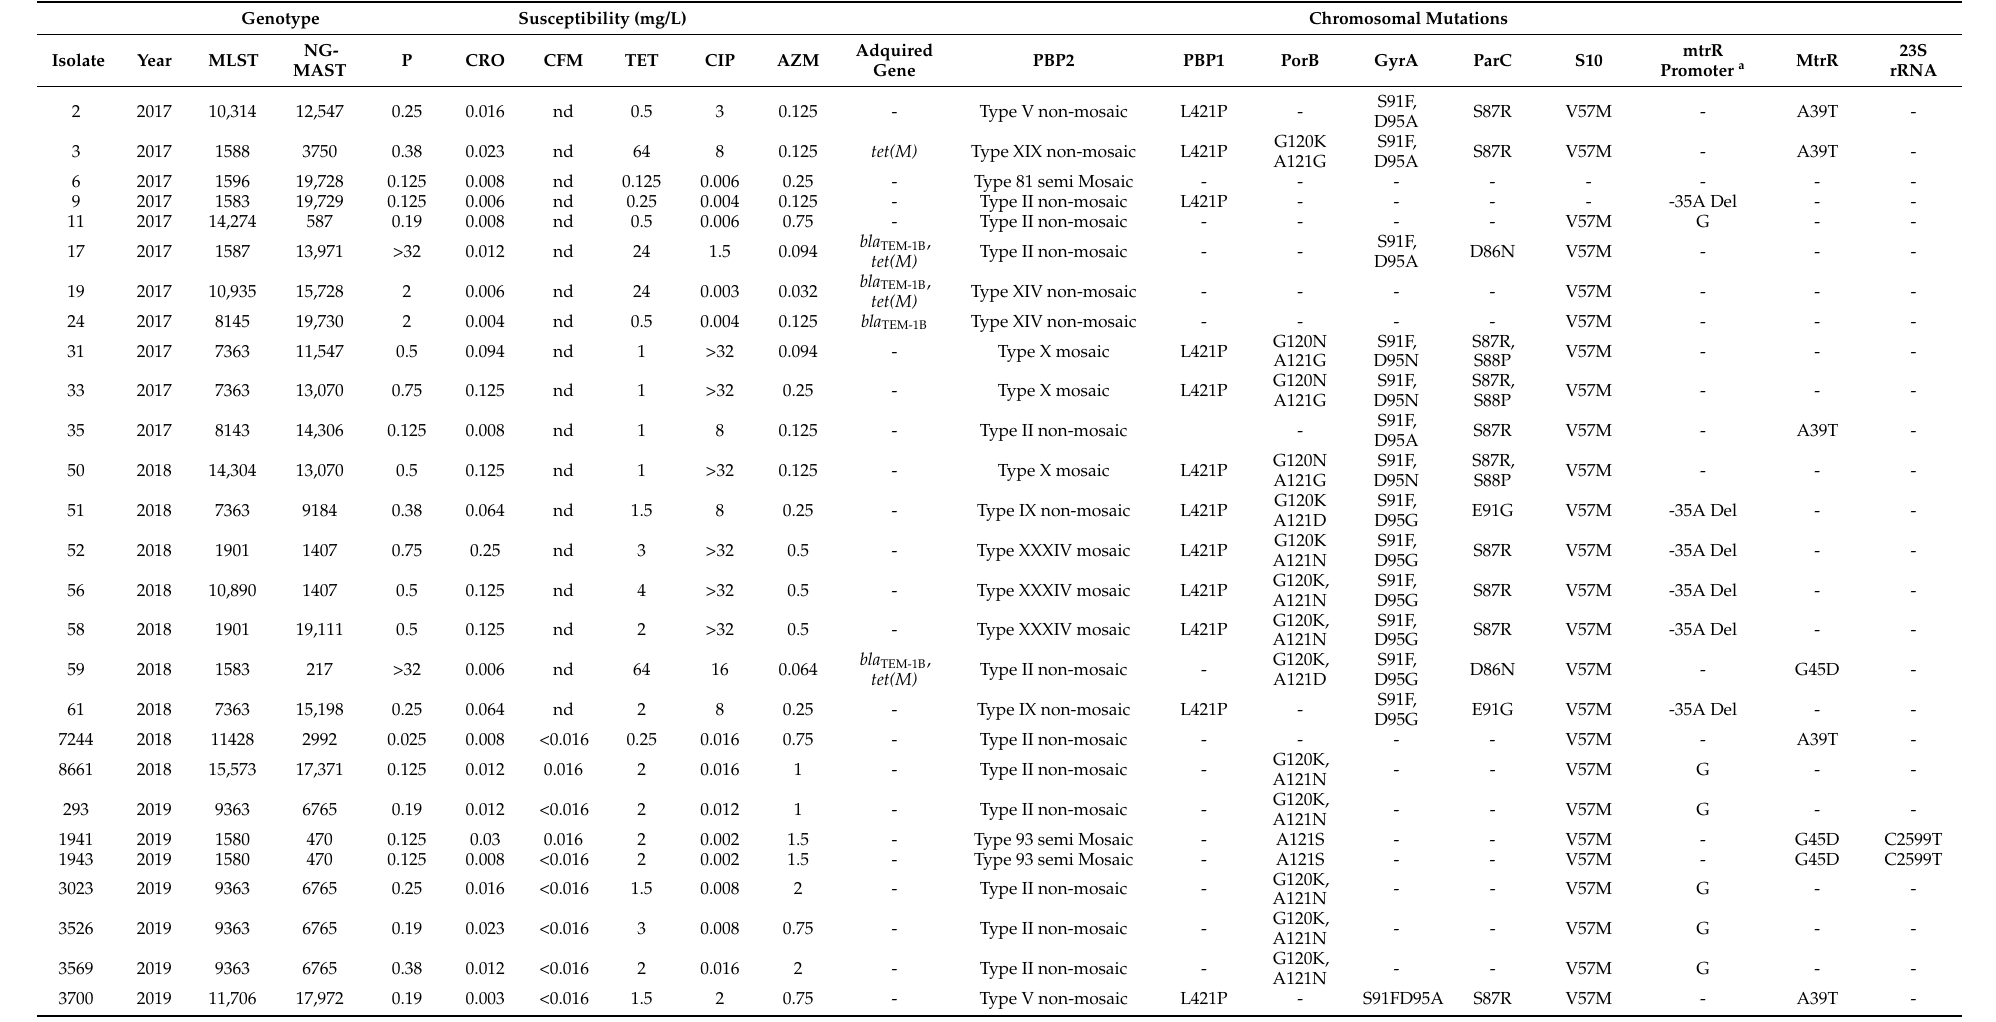
Table 3. Genotypes, MICs, and antimicrobial resistance determinants for the 35 Neisseria gonorrhoeae isolates sequenced by WGS.